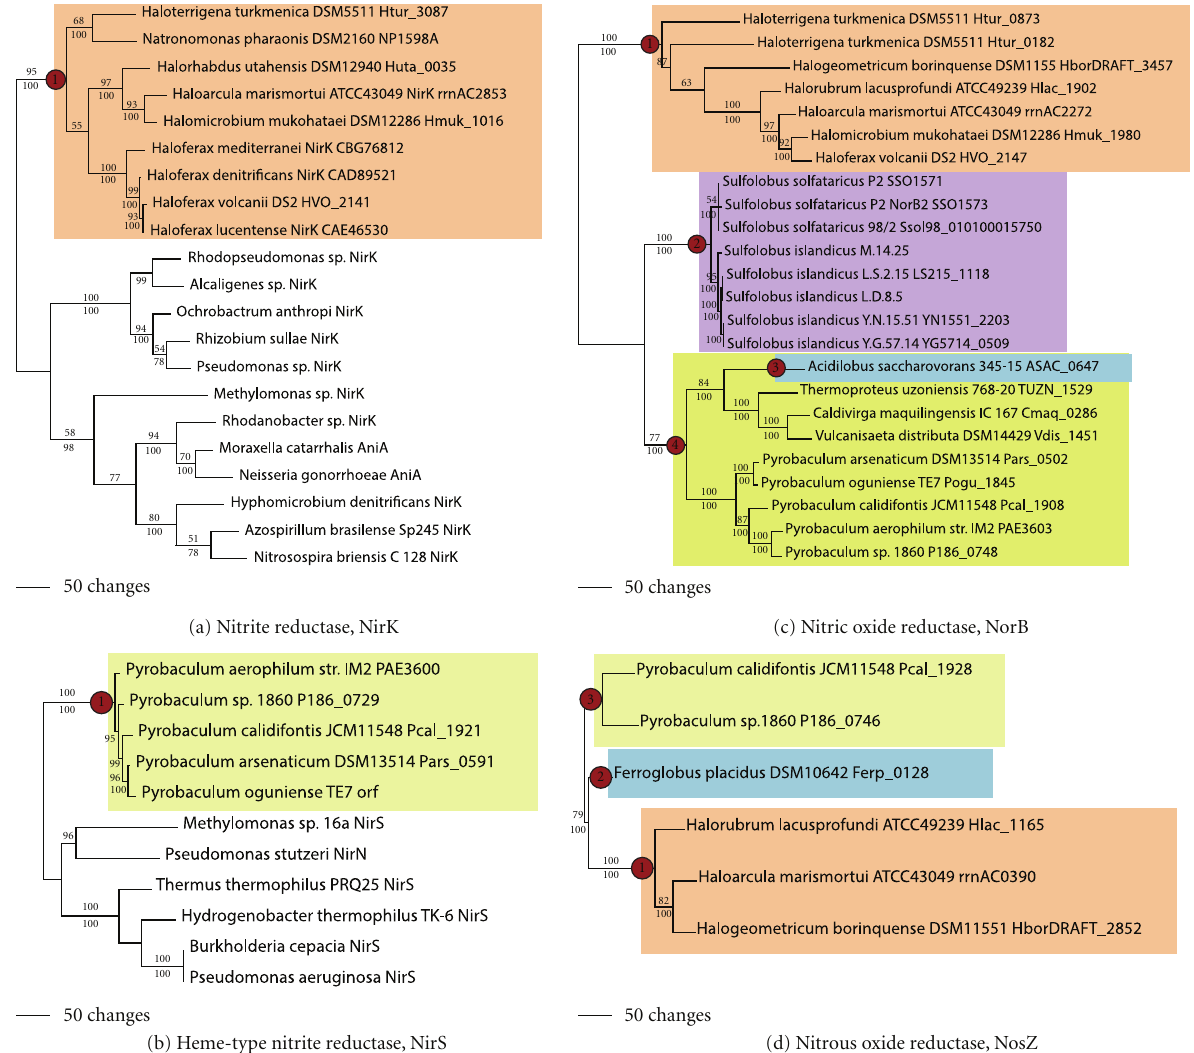
Figure 11: Nitrite reduction. Phylogenetic trees for (a) Cu-containing nitrite reductase beta subunit (NirK), (b) Heme-containing nitrite reductase (NirS), (c) nitric oxide reductase (NorB), and (d) nitrous oxide reductase (NosZ).